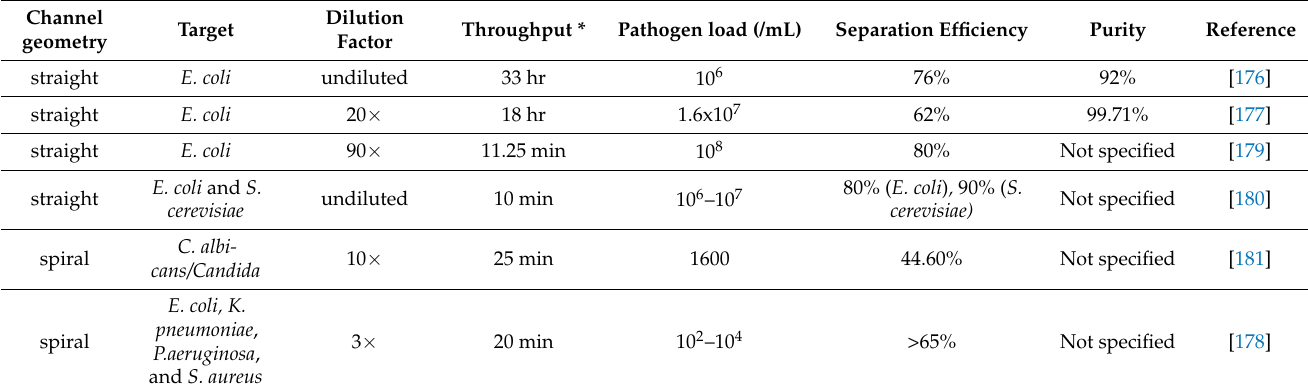
Table 3. Summary of parameters and performance of devices used for bacteria and fungus